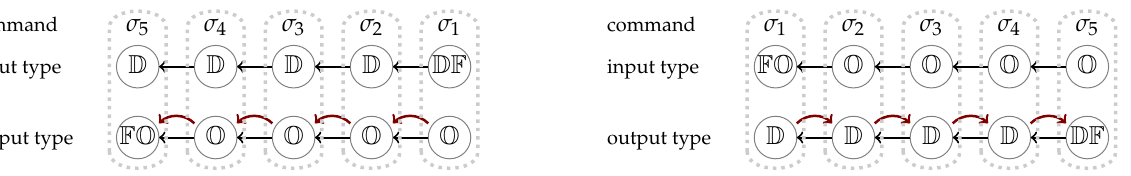
Figure 2. Structure of an up (left) and down (right) (cid:28) -chain. Black arrows point to the parent node and red arrows show the execution order (cid:28)